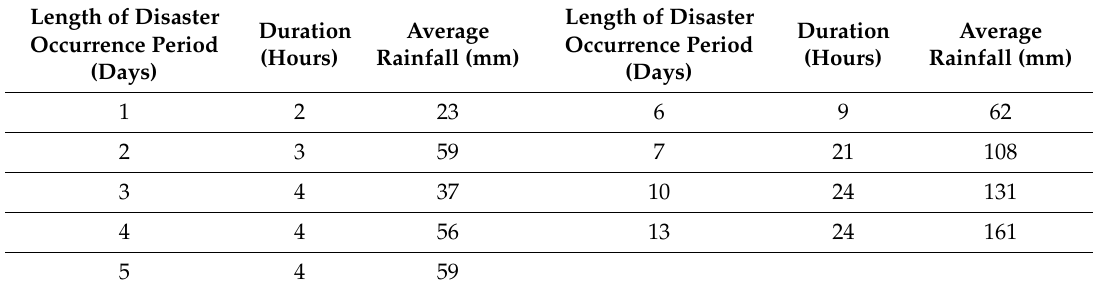
Table 8. Parameters for the equation of disaster-prevention rainfall estimation of urban area. Length of Disaster